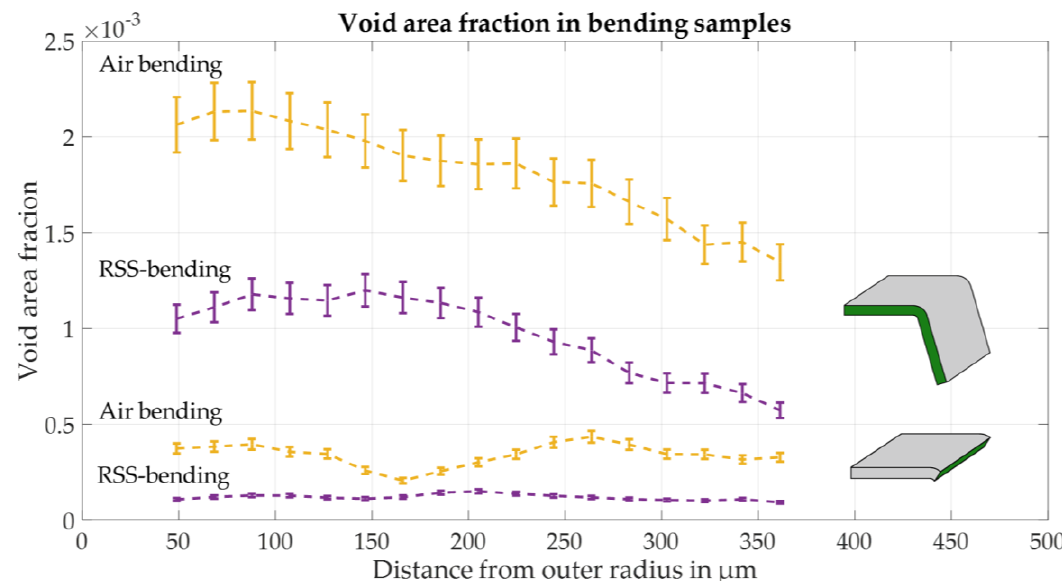
Figure 10. Void area fraction in air bending and RSS bending in the outer fibers measured by SEM imaging and automated void recognition.